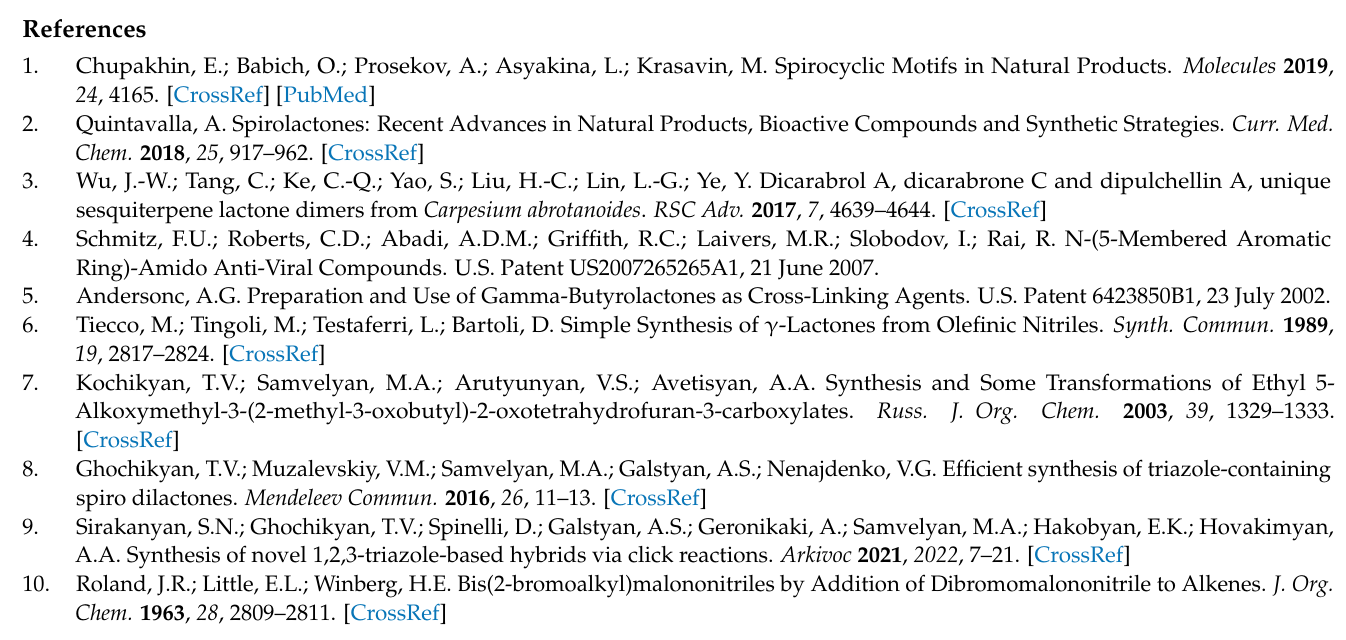
Figure S13: 1 H NMR of 3,8-bis(naphthalen-1-ylmethylene)-2,7-dioxaspiro[4.4]nonane-1,6-dione ( 5g ); Figure S14: 1 H NMR of 3,8-bis(naphthalen-1-ylmethylene)-2,7-dioxaspiro[4.4]nonane-1,6-dione ( 5g ); Figure S15: 1 H NMR of 3,8-bis(3-methoxybenzylidene)-2,7-dioxaspiro[4.4]nonane-1,6-dione ( 5h ); Figure S16: 13 C NMR of 3,8-bis(3-methoxybenzylidene)-2,7-dioxaspiro[4.4]nonane-1,6-dione ( 5h ); Figure S17: 1 H NMR of 3,8-bis(4-bromo-3-fluorobenzylidene)-2,7-dioxaspiro[4.4]nonane-1,6- dione ( 5i ); Figure S18: 13 C NMR of 3,8-bis(4-bromo-3-fluorobenzylidene)-2,7-dioxaspiro[4.4]nonane- 1,6-dione ( 5i ); Figure S19: 1 H NMR of 3,8-bis(4-chlorobenzylidene)-2,7-dioxaspiro[4.4]nonane-1,6- dione ( 5j ); Figure S20: 13 C NMR of 3,8-bis(4-chlorobenzylidene)-2,7-dioxaspiro[4.4]nonane-1,6- dione ( 5j ); Figure S21: 1 H NMR of 3,8-bis(4-bromobenzylidene)-2,7-dioxaspiro[4.4]nonane-1,6-dione ( 5k ); Figure S22: 13 C NMR of 3,8-bis(4-bromobenzylidene)-2,7-dioxaspiro[4.4]nonane-1,6-dione ( 5k ); Figure S23: 1 H NMR of 3,8-bis(2-methyl-5-nitrobenzylidene)-2,7-dioxaspiro[4.4]nonane-1,6-dione ( 5l ); Figure S24. 13 C NMR of 3,8-bis(2-methyl-5-nitrobenzylidene)-2,7-dioxaspiro[4.4]nonane-1,6-dione ( 5l ); Figure S25: 1 H NMR of 3-(4-chlorobenzylidene)-8-(4-methoxybenzylidene)-2,7-dioxaspiro[4.4] nonane-1,6-dione ( 5m ); Figure S26: 13 C NMR of 3-(4-chlorobenzylidene)-8-(4-methoxybenzylidene)- 2,7-dioxaspiro[4.4]nonane-1,6-dione ( 5m ); Figure S27: 1 H NMR of 3,8-bis(2-methoxybenzylidene)- 2,7-dioxaspiro[4.4]nonane-1,6-dione ( 5n ); Figure S28: 1 H NMR of 3,8-bis(2-methoxybenzylidene)-2,7- dioxaspiro[4.4]nonane-1,6-dione ( 5n